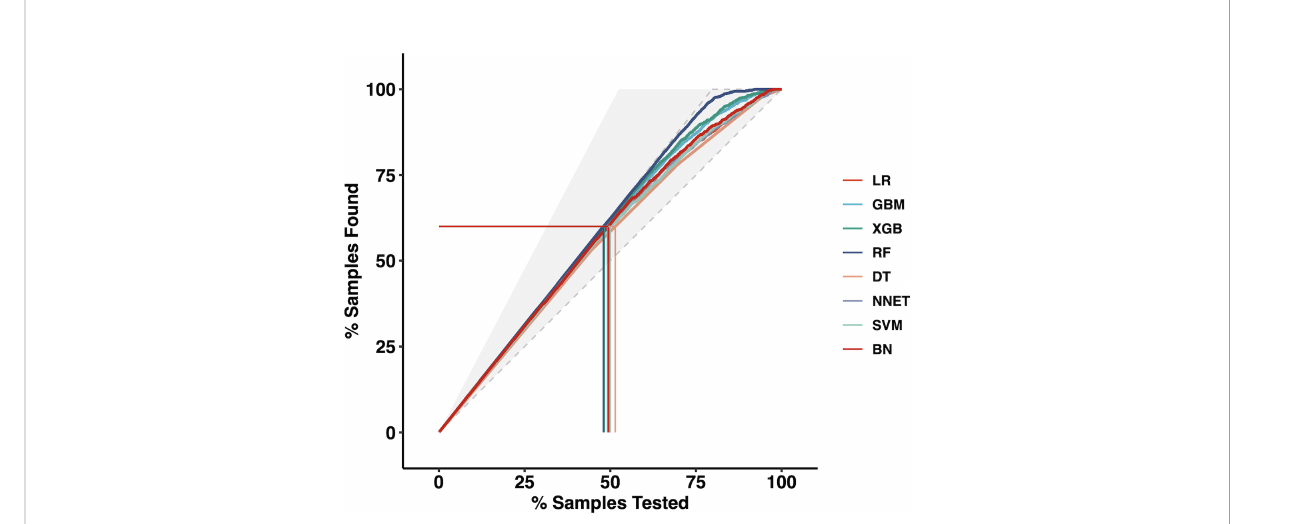
FIGURE 2 The mixed Lift curves of the eight machine learning models in the training cohort. LR Logistic Regression; GBM Gradient Boosting Machine; XGB Extreme Gradient Boosting; RF Random Forest; DT Decision Tree; NNET Neural Network, SVM Support Vector Machine; BN Bayesian